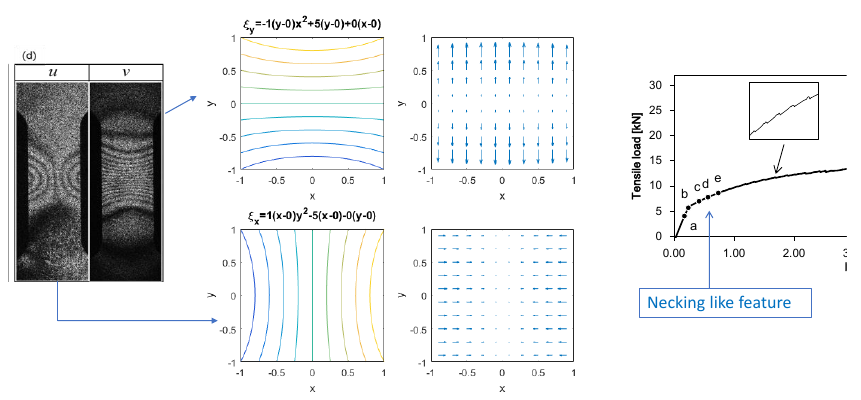
Figure 6. Differential displacement fields at Post-Yield 2 stage represented by fringe pattern (d) in Figure